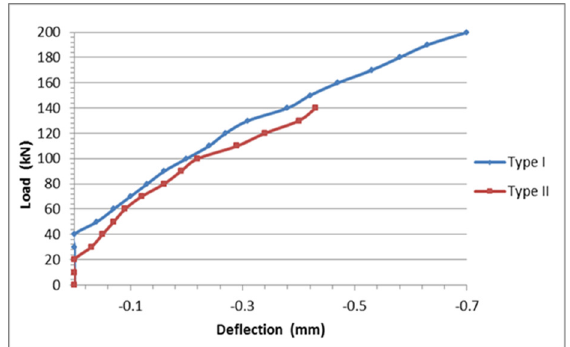
Fig. 12. Effect of Subgrade Type on Load-deflection (Loaded Slab).